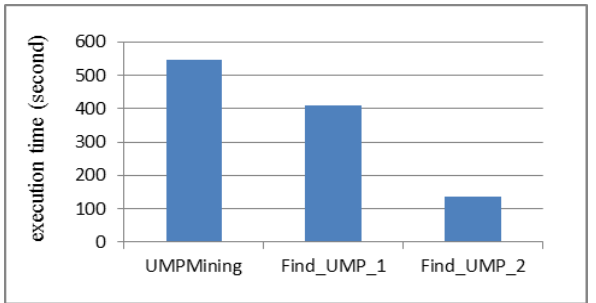
Figure 4 . The execution time total of three algorithms